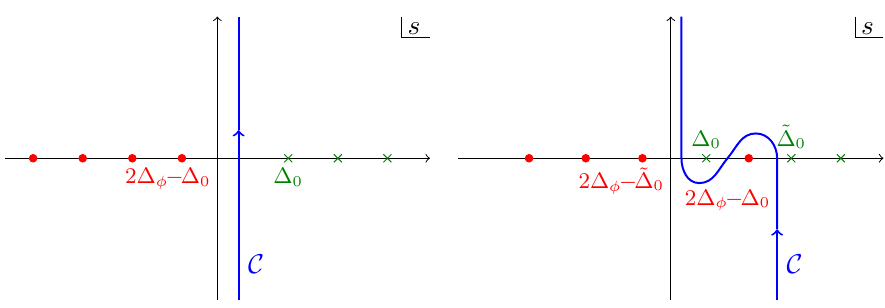
Figure 1 . Left : the contour for the inverse Mellin transform when ∆ 0 > ∆ φ . Left poles are marked in red and right poles are green. Right : when ∆ needs to be